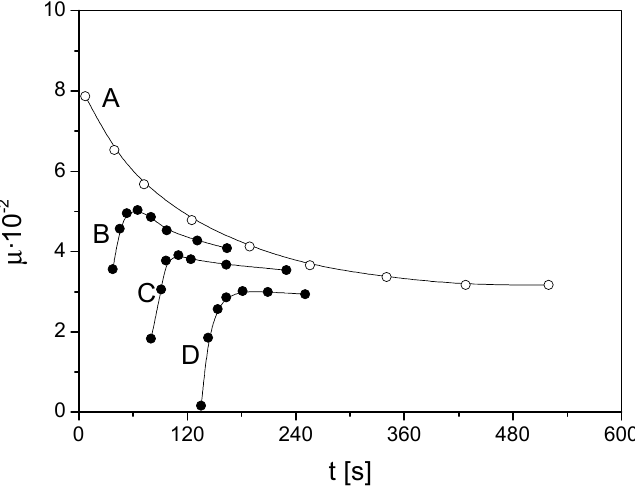
Figure 10. Magnetic permeability µ r from time t after demagnetization; Webb–Ford effect in silicon steel, curve A for time t = 0 from the time of demagnetization, curves B, C, D—for later times ti.